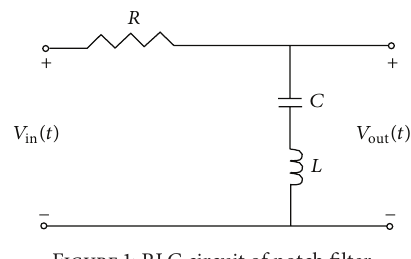
Figure 1: RLC circuit of notch filter.